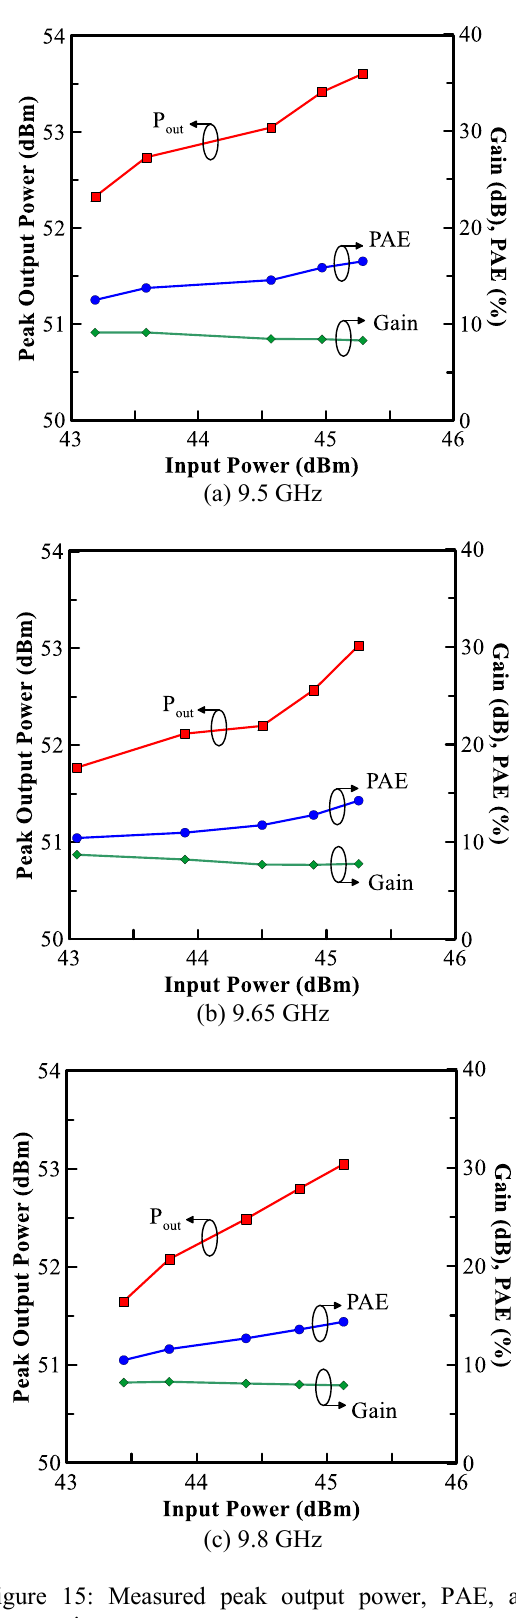
Figure 15: Measured peak output power, PAE, and power gain.